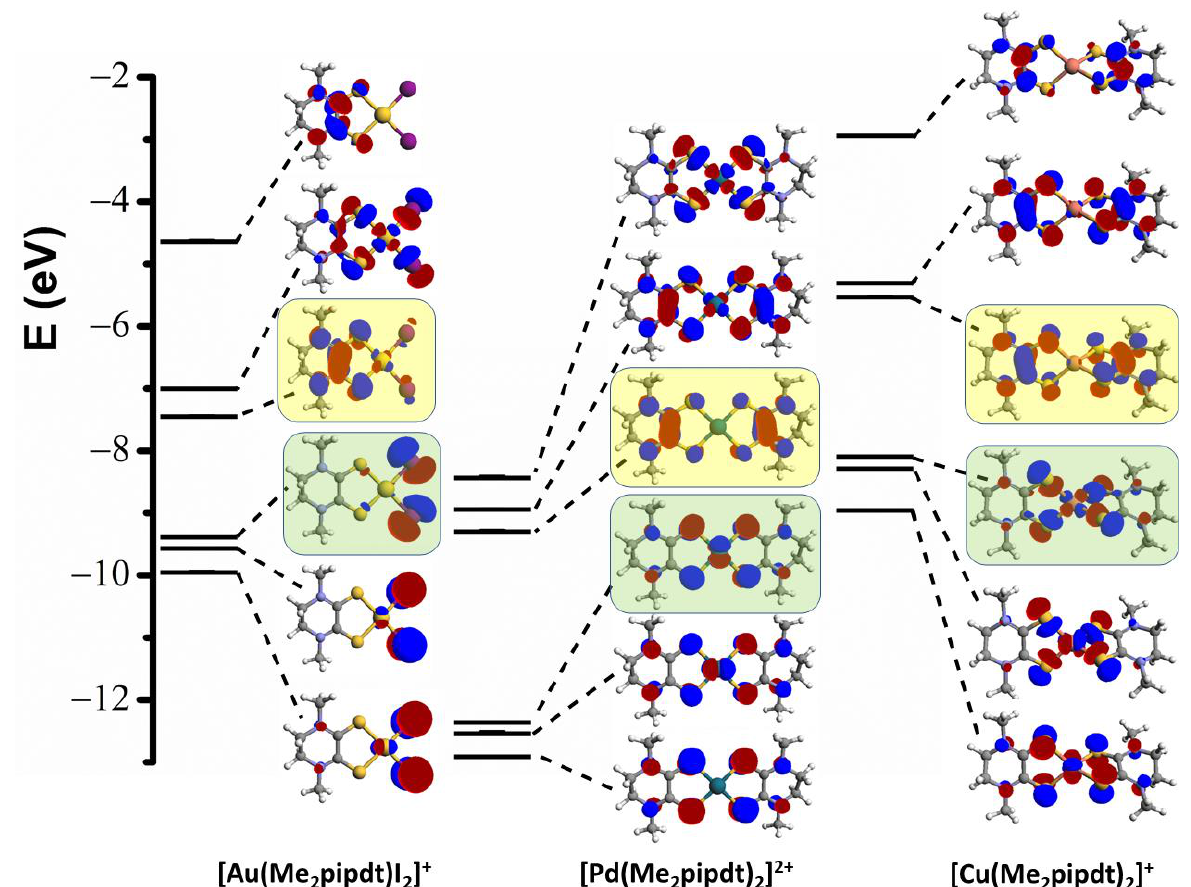
Figure 7. DFT calculated molecular orbitals and orbital diagram for cationic complexes 1 ′ , 2′ and 3′ . Starting from the upper part, the figure depicts all the MO ranging from the LUMO+2 to the HOMO-2; for each complex, HOMO and LUMO are highlighted in pale green and yellow colors, respectively (isovalue = 0.04).